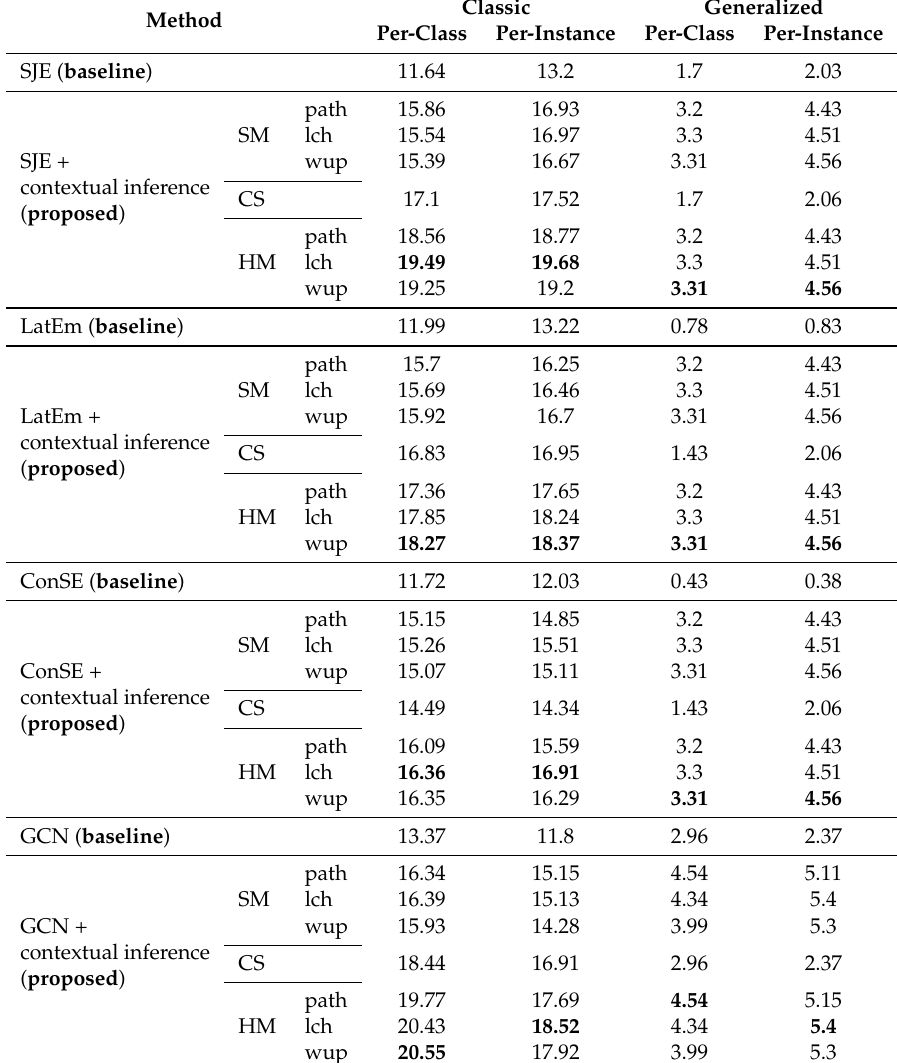
Table 2. Comparative results to the baseline models. Numerical values represent